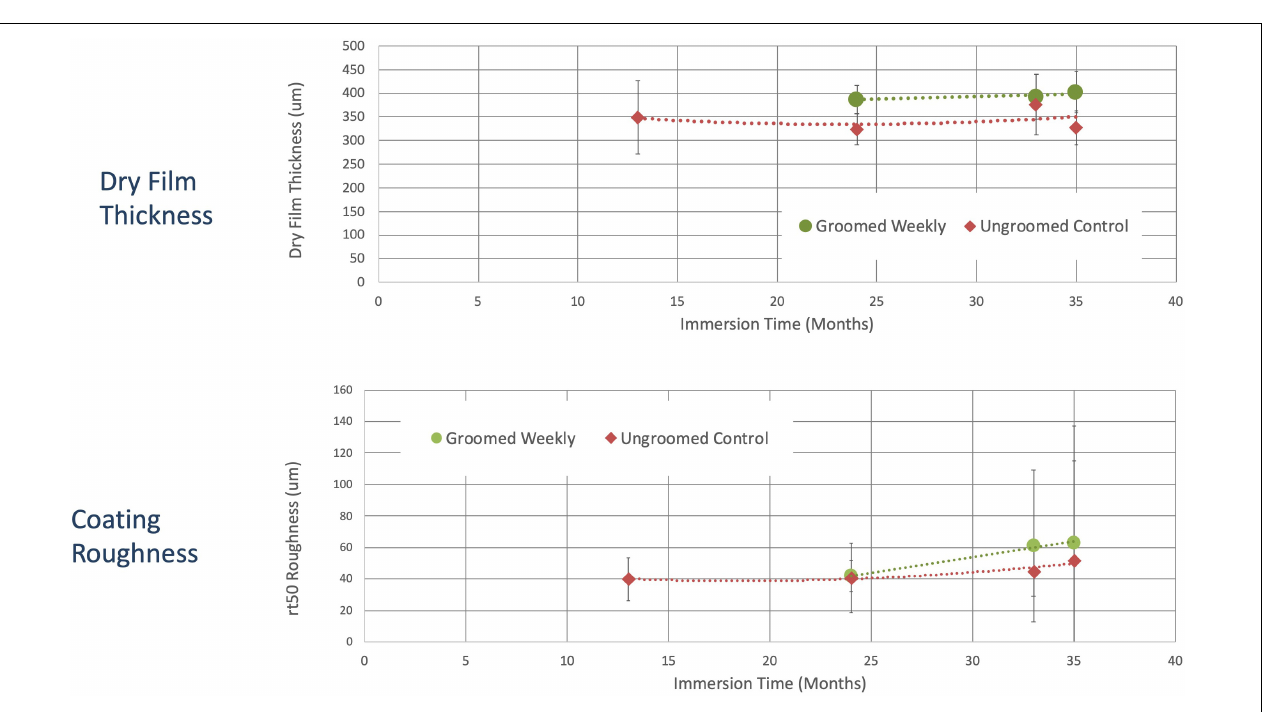
about 150 microns. The removal of 150 microns DFT BRA640 would release 0.2 kg copper/m 2 into the